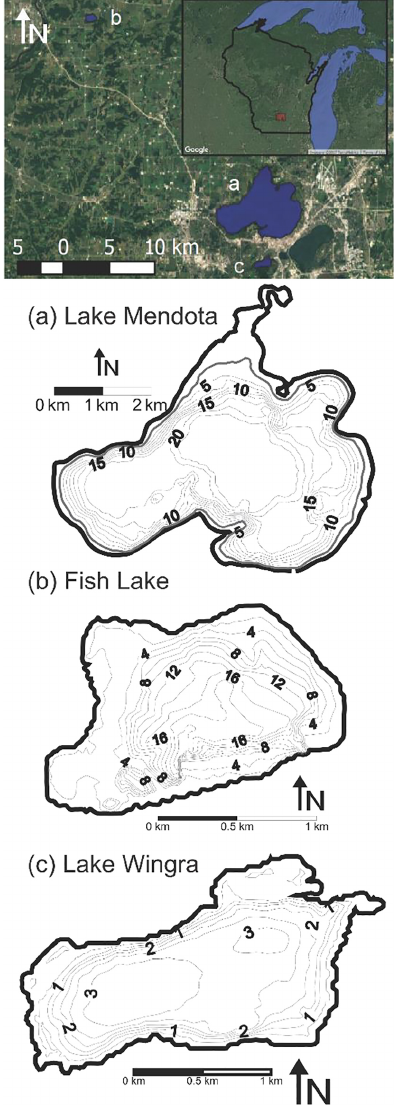
Figure 1. (Top) map of study lakes in Wisconsin, USA and bathy- metric maps of each lake: (a) Lake Mendota, (b) Fish Lake, and (c) Lake